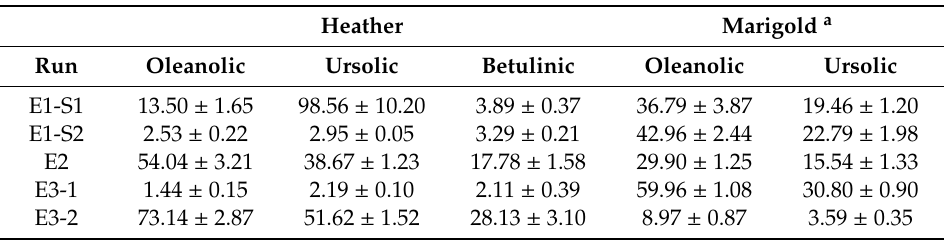
Table 3. Concentration (mg / g extract) of oleanolic, ursolic and betulinic acid in heather and marigold extracts obtained by